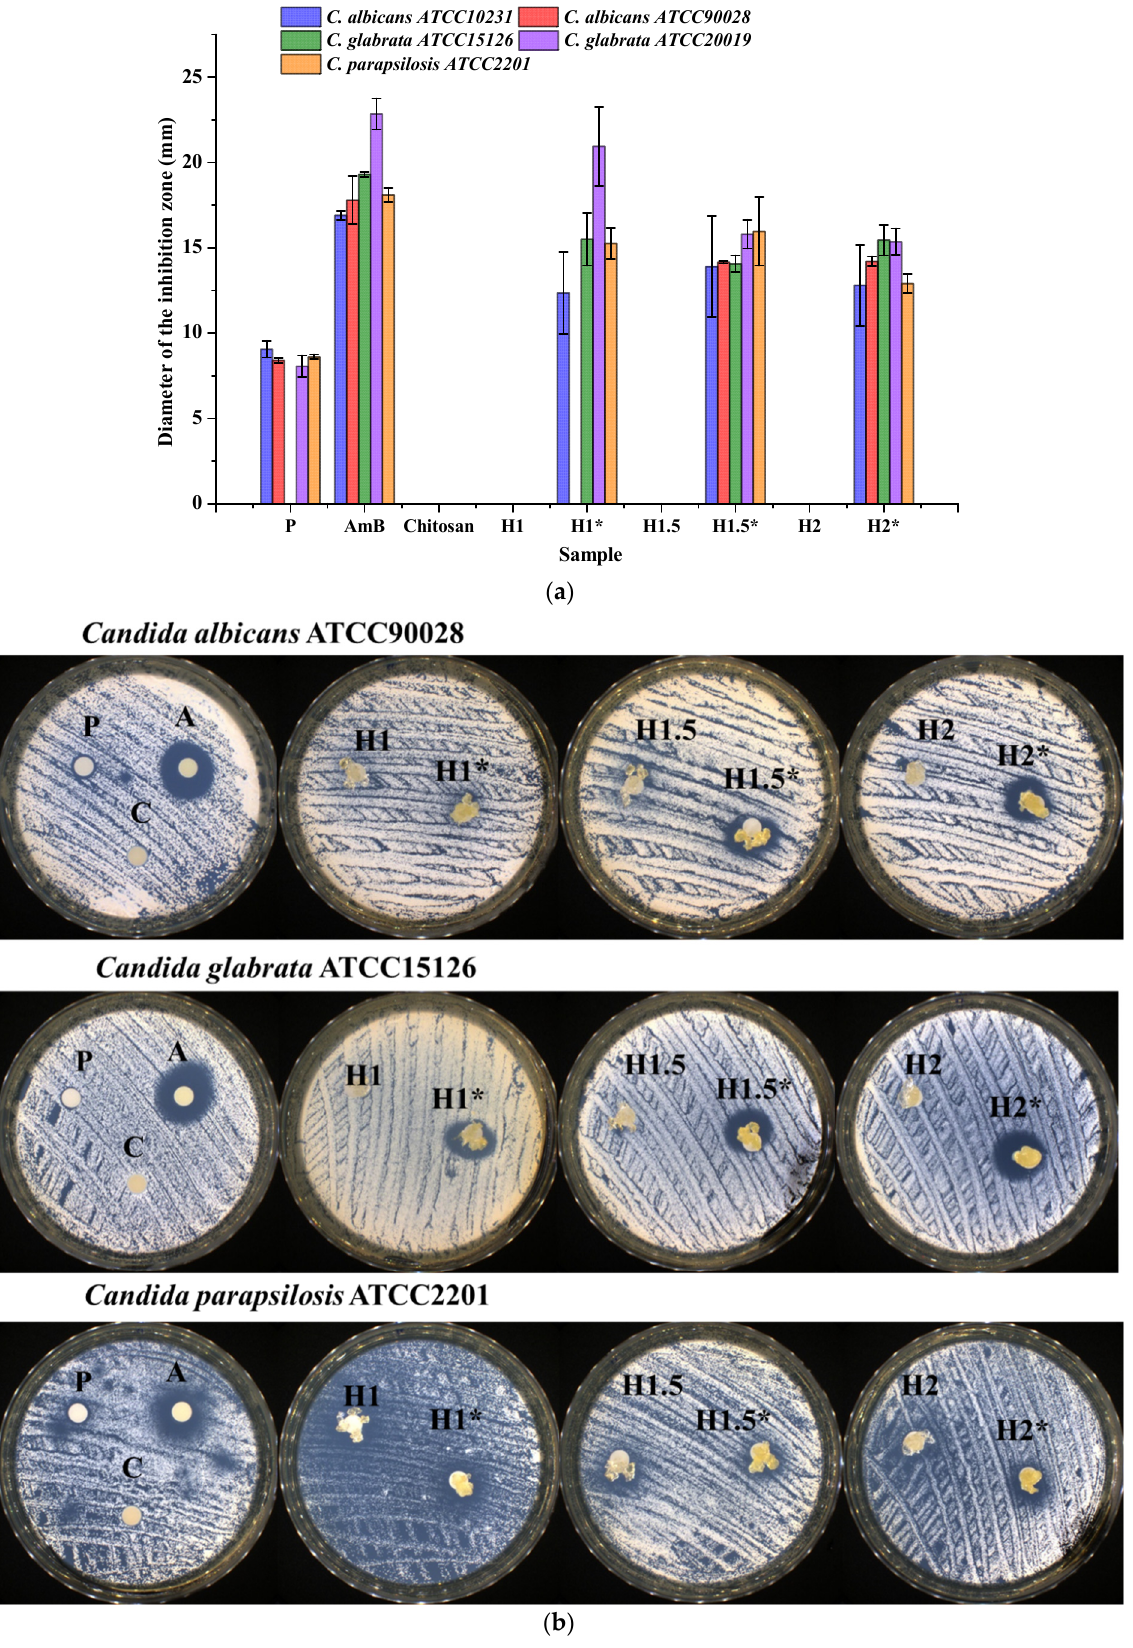
Figure 7. Antifungal activity (mm) of the samples against the reference strains ( a ) and representa- tive pictures taken during the exeriments ( b ). pictures taken during the exeriments ( b